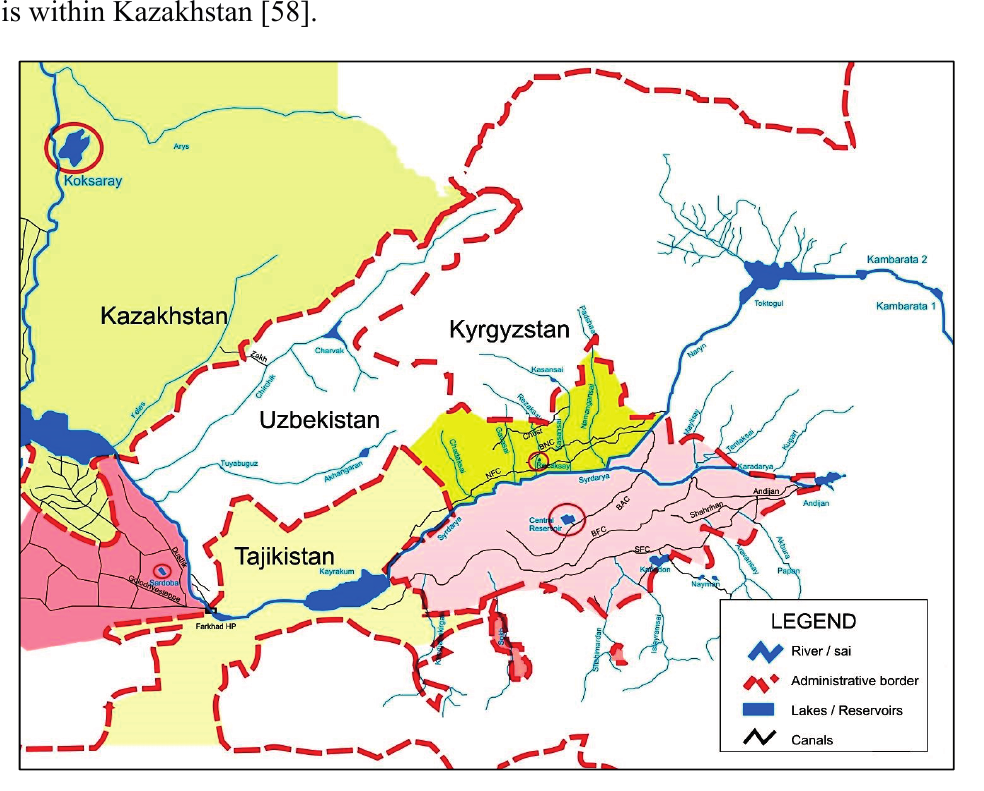
Figure 3. New reservoirs in the Syr Darya. (Source: Based on information compiled through GIS maps, as well as key informer BVO Syr